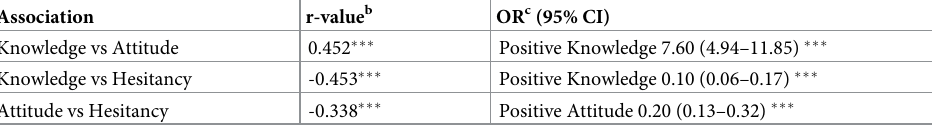
Table 5. Association in knowledge, attitude, and hesitancy domain towards COVID-19 vaccine ( n = 449).